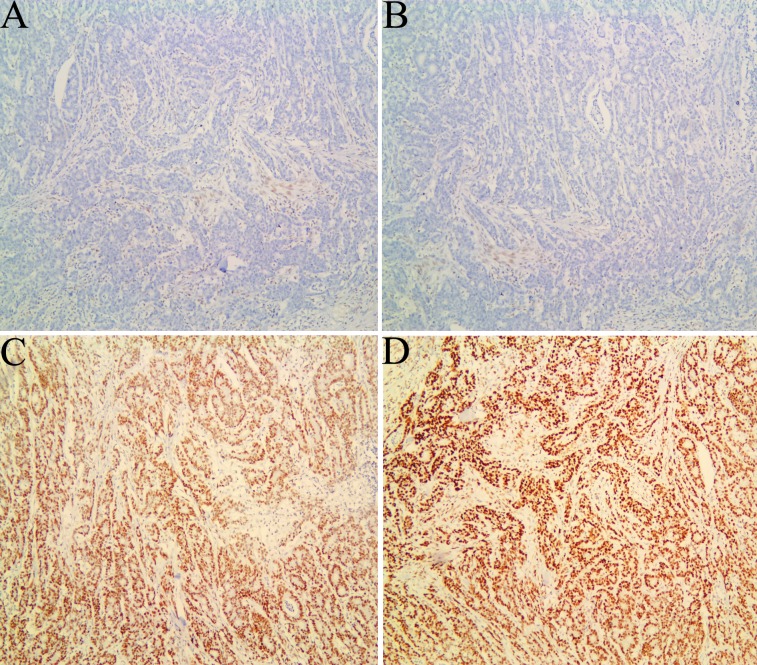
Immunohistochemical staining for mismatch repair proteins in one case of colorectal carcinoma.Tumor cells with absent MLH1 (A) and PMS2 (B) expression, and with MSH2 (C) and MSH6 (D) expression, which were regarded as deficient MMR. Note the presence of positive staining in stromal cells and lymphocyte serving as internal positive controls.